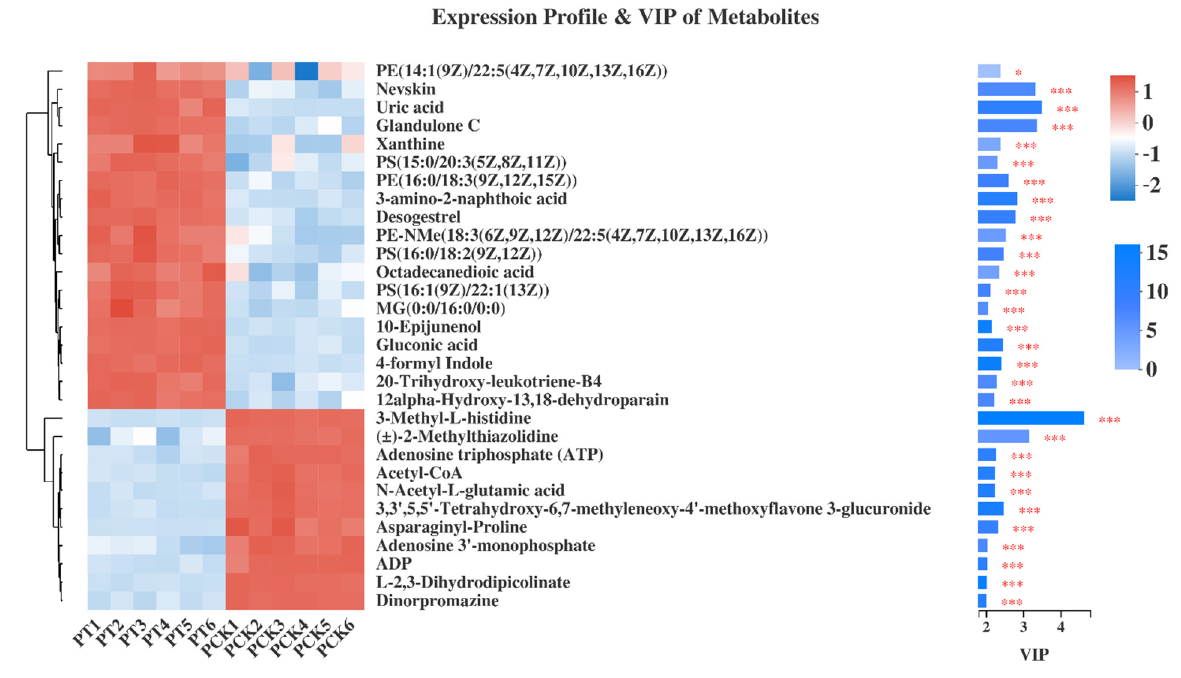
Figure 4. Expression profile and VIP of top 30 metabolites in PT (PT1, PT2, PT3, PT4, PT5, and PT6) vs. PCK (PCK1, PCK2, PCK3, PCK4, PCK5, and PCK6) group. Levels of significance are defined as * p < 0.05, and *** p < 0.001 .